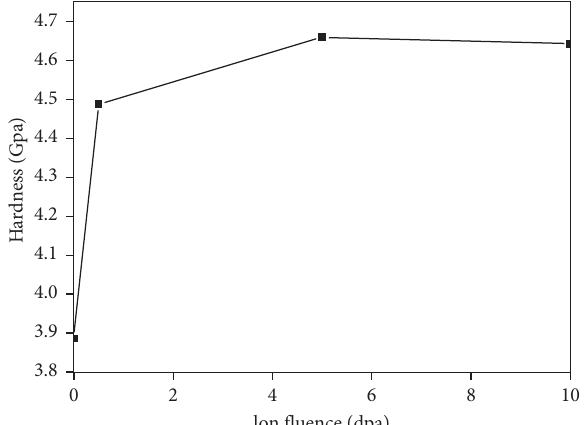
Figure 11: Trend of the average hardness value of Hastelloy N alloy samples in the depth range of 200–1600nm before and after ion irradiation to different